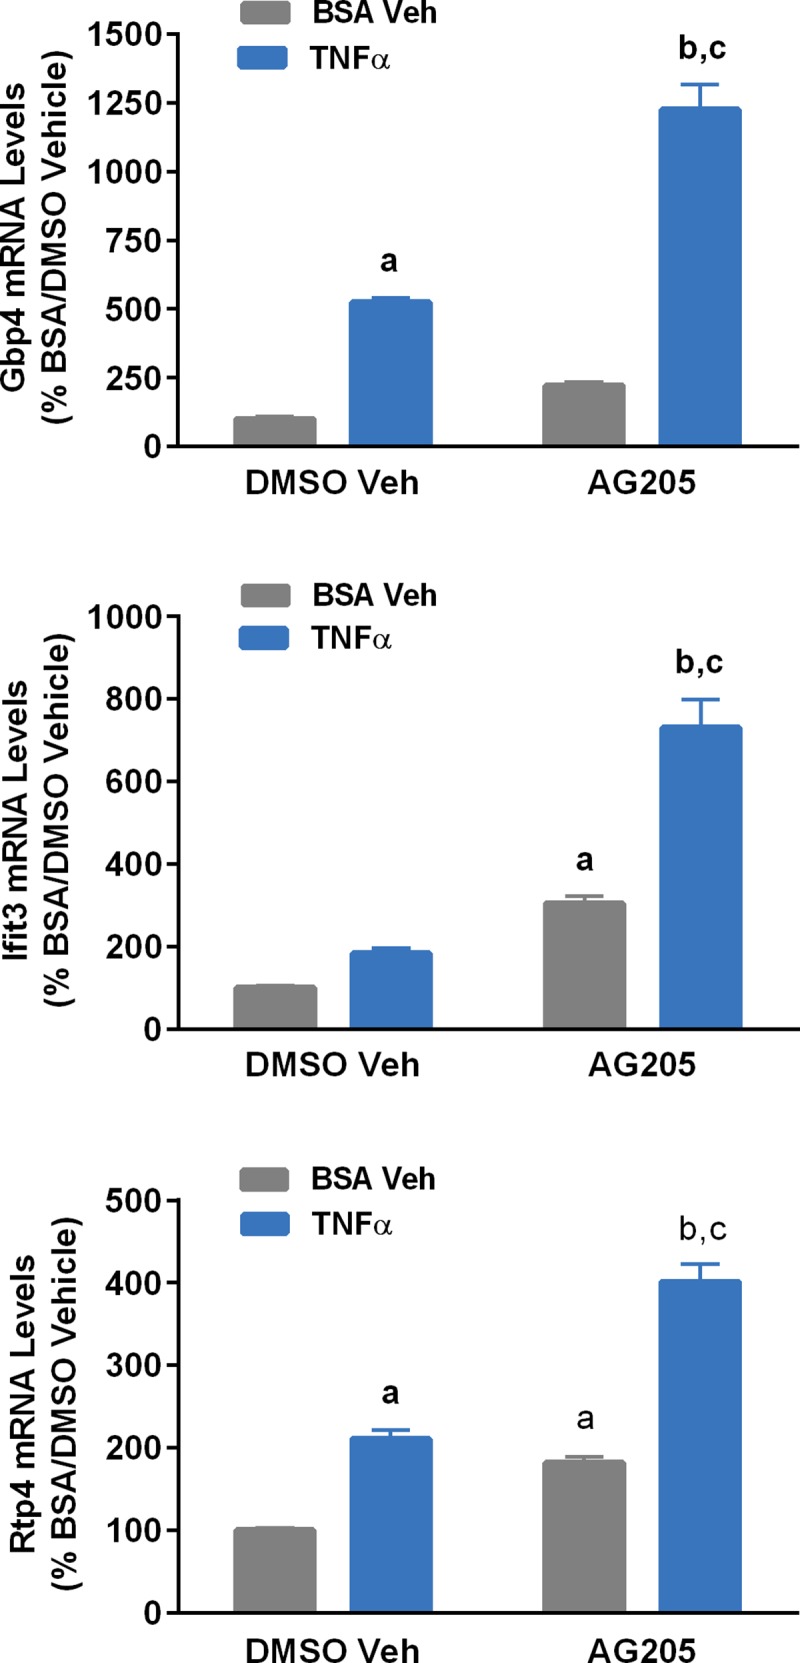
Effects of Pgrmc1 antagonist, AG-205 on TNFα (10 ng/ml) regulation of Gbp4 (top panel), Ifit3 (middle panel) and Rtp4 (bottom panel) mRNA levels in N42 cells. Bars represent mean ± SEM. (aSignificantly different from control cells treated with DMSO vehicle, p<0.0001; bsignificantly different from cells treated with TNFα + vehicle; csignificantly different from cells treated with AG205+vehicle, p<0.0001).